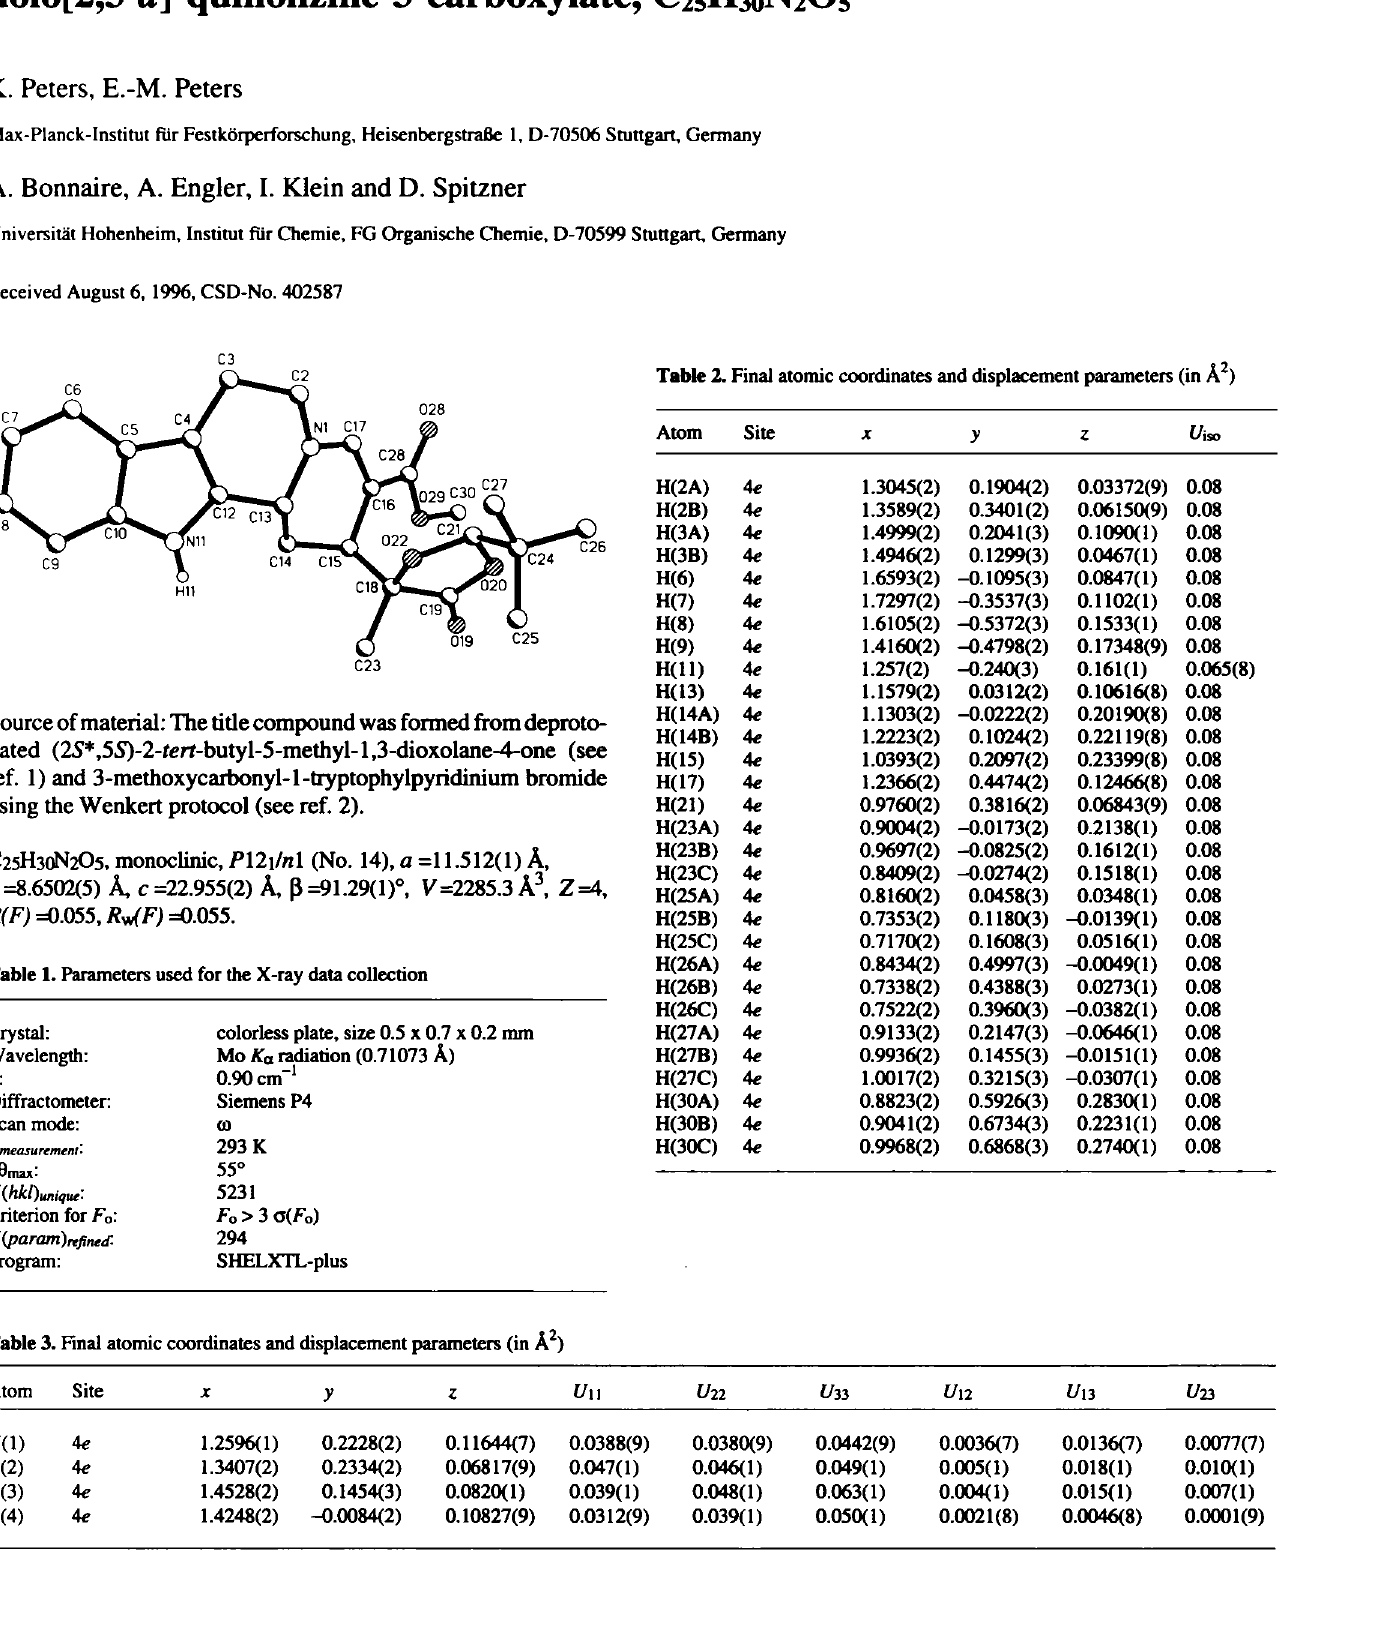
Table 3. Final atomic coordinates and displacement parameters (in Â 2 )